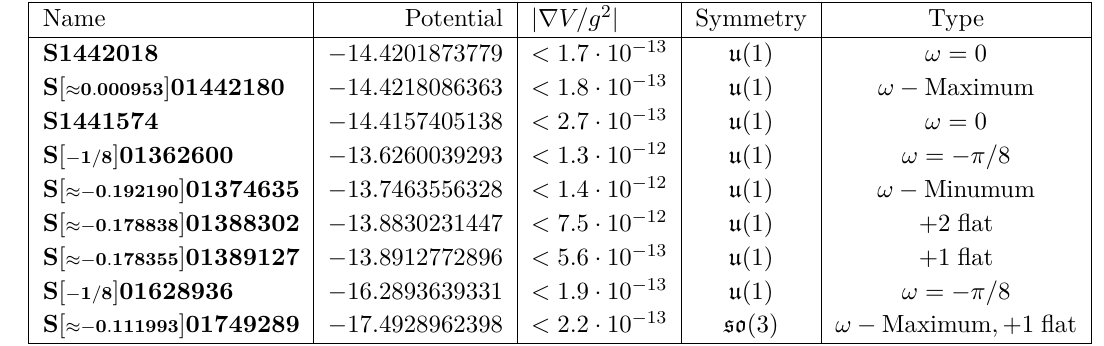
Table 2. Properties of the vacua displayed in figure